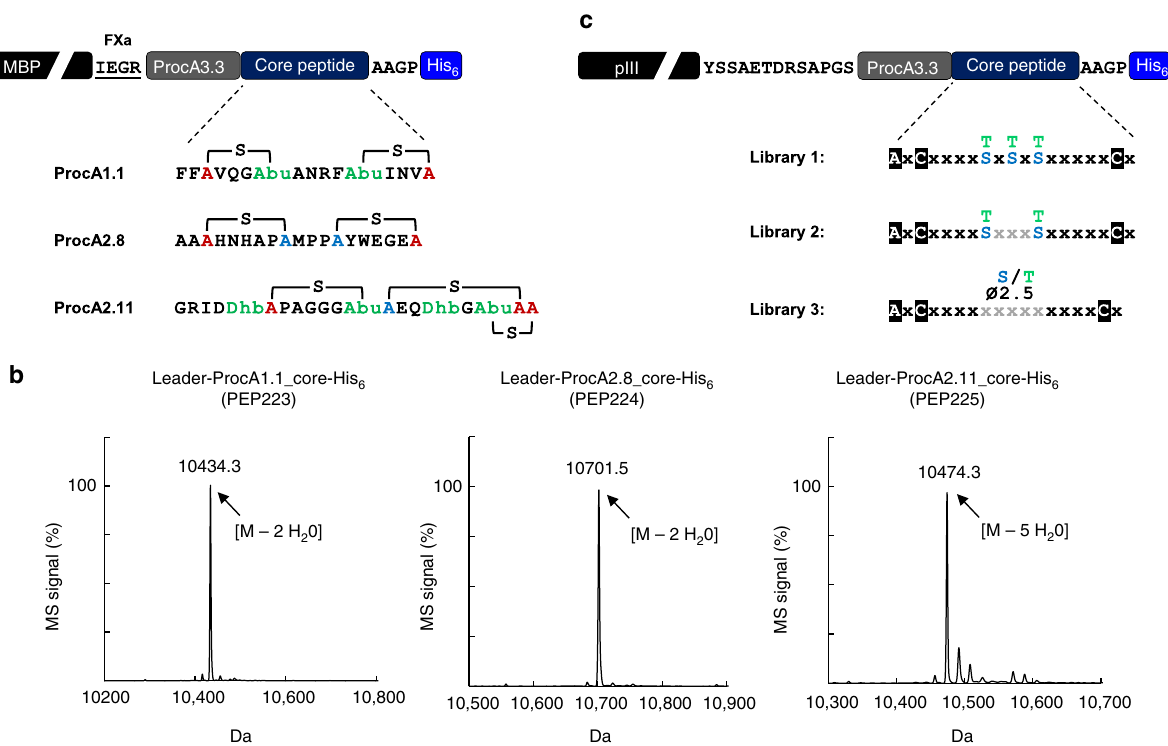
Fig. 3 ProcM-mediated enzymatic modi fi cation of natural prochlorosin variants fused to the C-terminus of MBP and design of phage display libraries. a Sequence of natural prochlorosin core peptides with thioether bridges (brackets) and modi fi ed residues (colored) in context of C-terminal MBP fusions (the ProcA3.3. leader, linker sequences with FXa site and His 6 -tag are indicated; for full sequences see Supplementary Table 5). b ESI mass spectra of prochlorosins produced as C-terminal MBP fusions in presence of ProcM co-expression and analyzed as leader-core peptides after proteolytic removal of MBP and IMAC puri fi cation. The main peak peptide masses re fl ect fully dehydrated core peptides and the number of identi fi ed dehydrations is indicated (each − 18 Da). c Schematic representation of lanthipeptide precursor libraries fused to the C-terminus of pIII (linker sequences as indicated). In the library sequences white, boxed letters indicate fi xed residues, x (black) represents all possible amino acids (except cysteine, threonine, and serine) at equal distribution. In library design 1 and 2, three or two fi xed threonines or serines (blue and green) were incorporated at equal distribution, respectively. X (gray) in library 2 indicates all possible amino acids (except cysteine) at equal distribution. In library design 3, serines or threonines were distributed in a central stretch (indicated by x; gray) at an average rate of 2.5 per molecule with all other amino acids (except for cysteine) equally